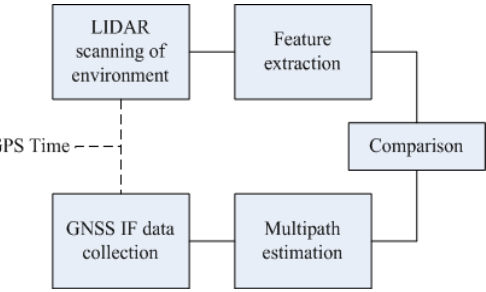
Figure 5. Block diagram of the process.